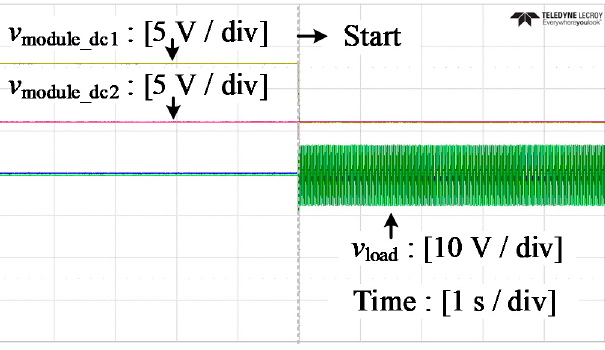
Figure 20. Experimental results of the lattice converter with dynamic voltage balancing.